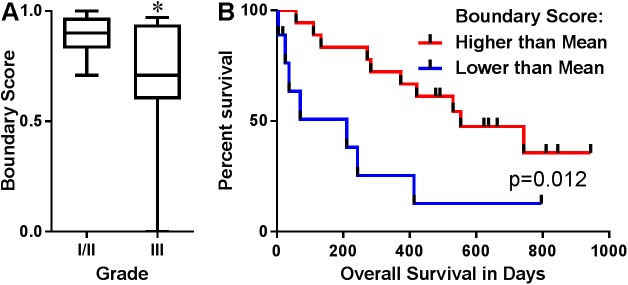
Absence of a tumor-stromal boundary predicts poor outcome in canine mammary tumors.A panel of 7 observers graded SHG images as having (1) or lacking (0) a tumor-stromal boundary. The boundary score for each tumor represents the average of the 7 evaluators’ scores and the 5 images per tumor. Boundary scores were compared between 15 grade I/II and 19 grade III tumors. *p<0.05 via a Mann-Whitney test (A). Kaplan-Meier survival curve for 27 dogs with boundary scores higher or lower than the mean boundary score (B). The log-rank test was used to evaluate whether the boundary score significantly impacted survival (p = 0.012, HR 0.316, 95%CI 0.092–1.087).